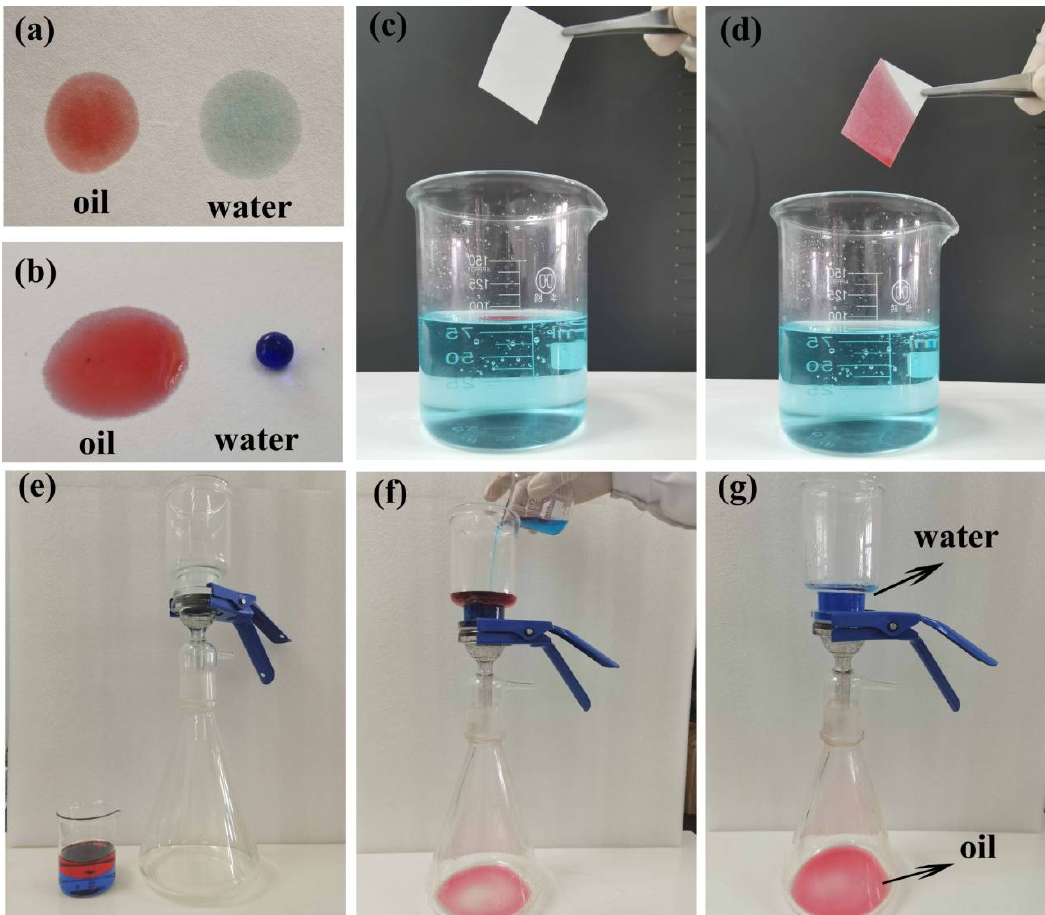
Figure 10. Wettability of ( a ) the paper and ( b ) the P 40 –P 4 –P 0.4 -coated superhydrophobic paper. ( c , d ) the process of superhydrophobic filter paper adsorbing oil from water. ( e – g ) oil − water- separation tests of the P 40 –P 4 –P 0.4 -coated superhydrophobic